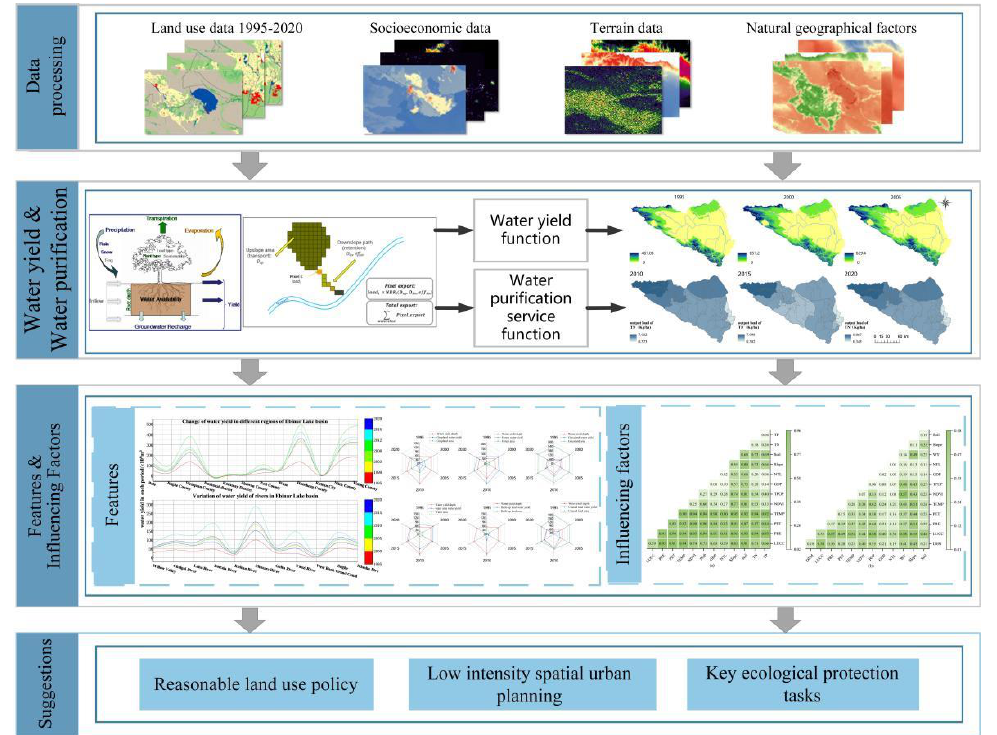
Figure 2. The research process of this study